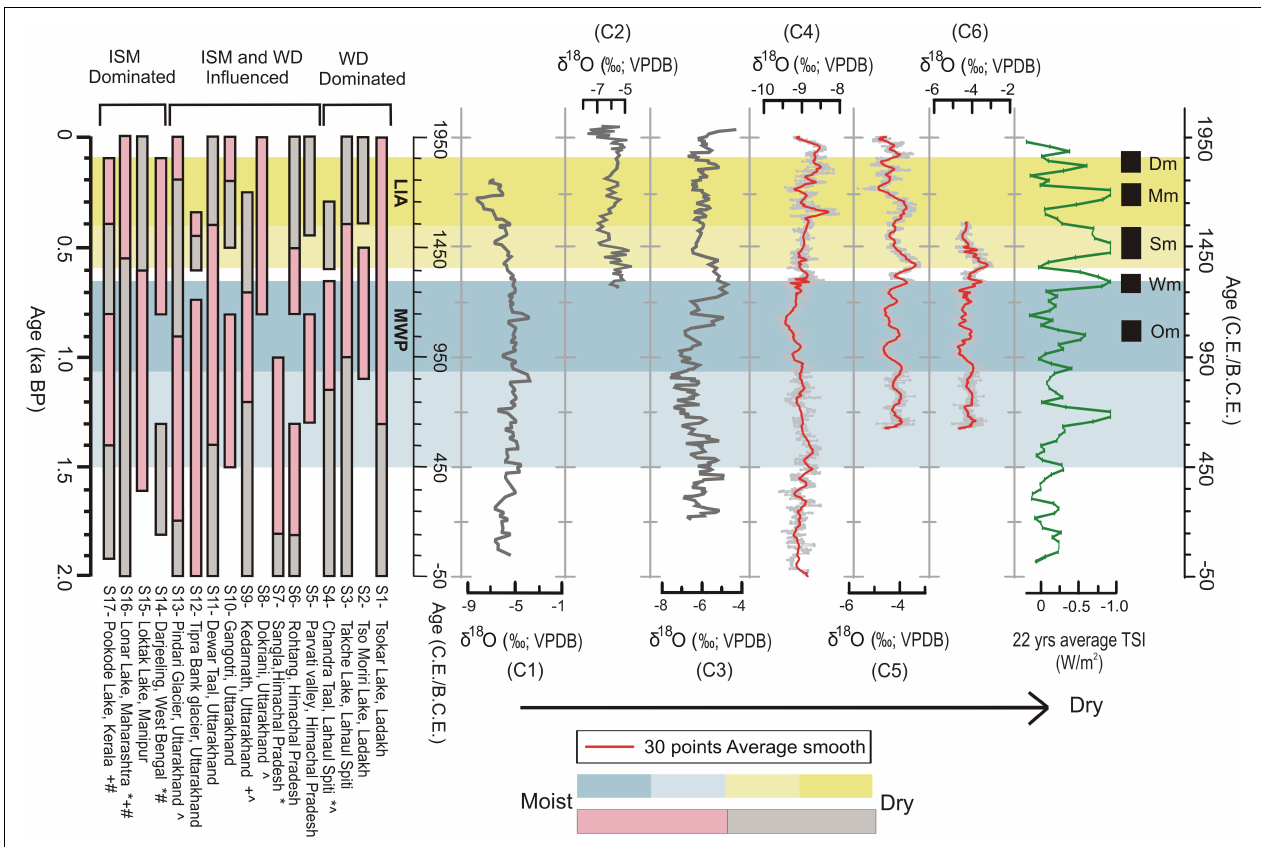
FIGURE 2 | Climatic episodes in sedimentary records of (S1) Demske et al. (2009); (S2) Leipe et al. (2014); (S3) Mazari et al. (1996); (S4) Rawat et al. (2015); (S5) Chauhan (2006); (S6) Bhattacharyya (1988); (S7) Chakraborty et al. (2006); (S8) Phadtare (2000); (S9) Srivastava et al. (2017); (S10) Kar et al. (2002); (S11) Chauhan and Sharma (2000); (S12) Bhattacharyya and Chauhan (1997); (S13) Bali et al. (2015); (S14) Ghosh et al. (2018); (S15) Nautiyal and Chauhan (2009); (S16) Prasad et al. (2014); (S17) Veena et al. (2014). All inferences are derived based on pollen assemblages additionally with δ 13 C org (*), Environment magnetism ( ∧ ), Other geochemical proxies (+), and other biotic proxies (#) as indicated in the figure. Palaeoclimate data of cave deposits; (C1) δ 18 O Sainji Cave (Kotlia et al., 2015); (C2) δ 18 O Panigarh Cave (Liang et al., 2015); (C3) δ 18 O Dharamjali Cave (Sanwal et al., 2013); (C4) δ 18 O Sahiya Cave (Sinha et al., 2015); (C5) δ 18 O Wah Shikar Cave (Sinha et al., 2011b); (C6) δ 18 O Dandak Cave (Berkelhammer et al., 2010). The 22 years average Total Solar Irradiance (TSI) dataset from Steinhilber et al. (2012) and sunspot minima activities: Oort (Om), Wolf (Wm), Spörer (Sm), Maunder (Mm), and Dalton (Dm) compared with the datasets. C1–C4 are influenced both by ISM and WD whereas C5–C6 are from ISM dominant